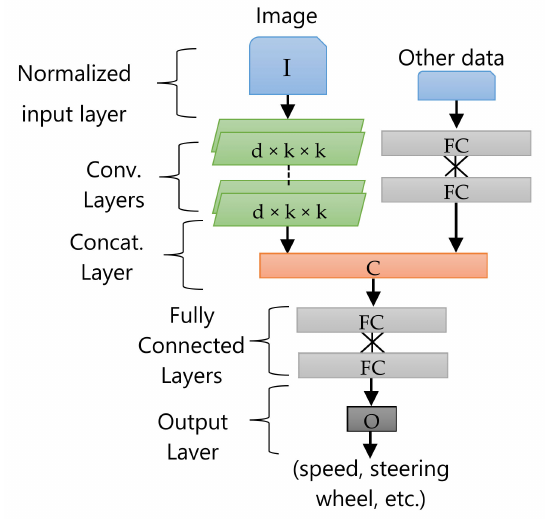
Figure 5. Mixed data e2e architecture (MiD).